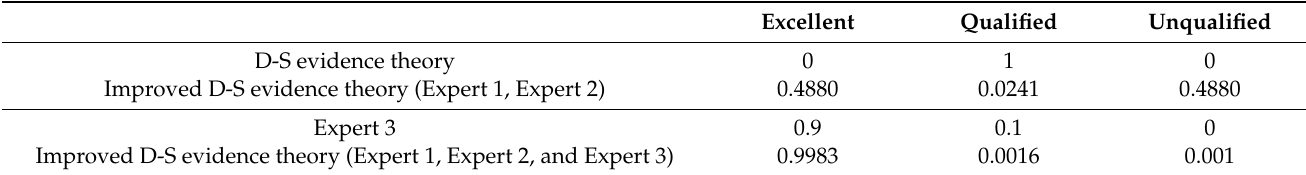
Table 6. Evidence fusion results in Example 1.